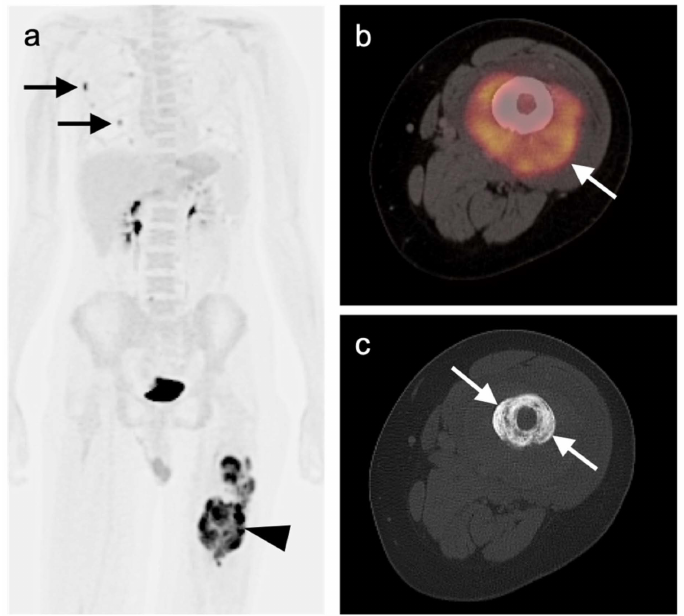
Figure 35. Ewing sarcoma of the left femur. ( a ) FDG PET MIP image demonstrates an intensely hypermetabolic left femoral mass (black arrowhead) and multiple small hypermetabolic lung nodules (black arrows). ( b ) Axial FDG PET-CT image of the left femur demonstrates a circumferential hypermetabolic soft tissue mass (white arrow) in the left femoral diaphysis, with metabolic activity extending through the bone to the medullary space. ( c ) Axial CT image of the left femur demonstrates lamellated concentric (onion-skin) cortical thickening, typical of Ewing sarcoma (white